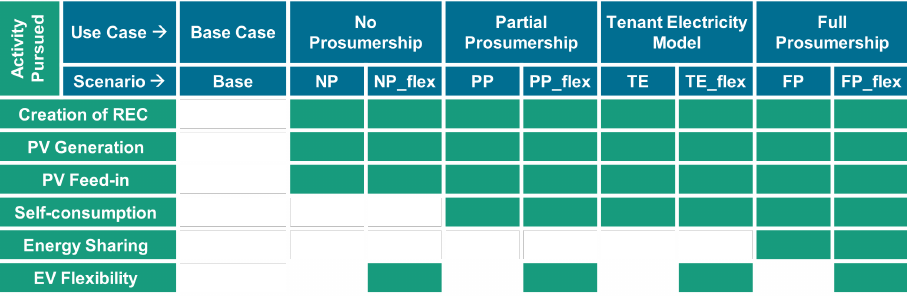
Figure 2. Use Cases and scenarios based on different degrees of prosumership pursued in a REC. The cells shaded in green imply that the activity has been pursued while empty cells imply that the activity has not been